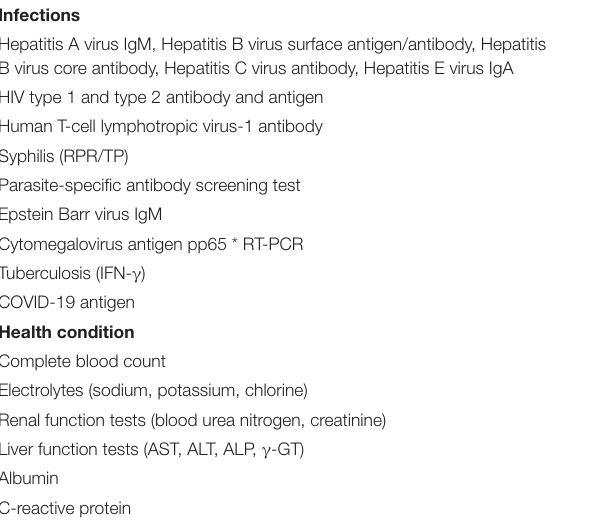
TABLE 2C | Donor screening criteria: fecal test.